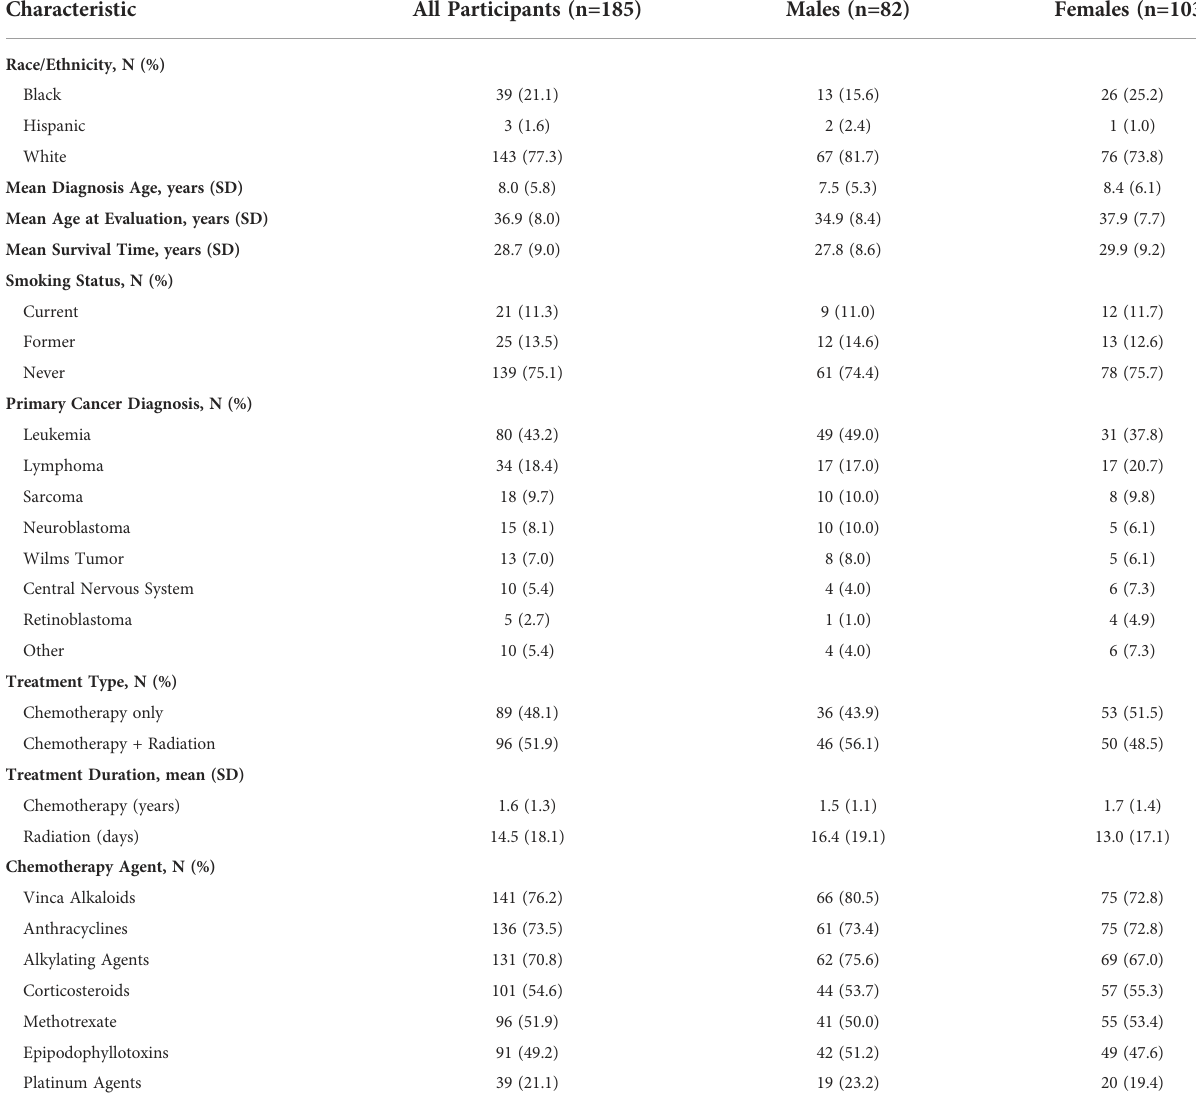
TABLE 1 Demographic and primary cancer characteristics of survivors of childhood